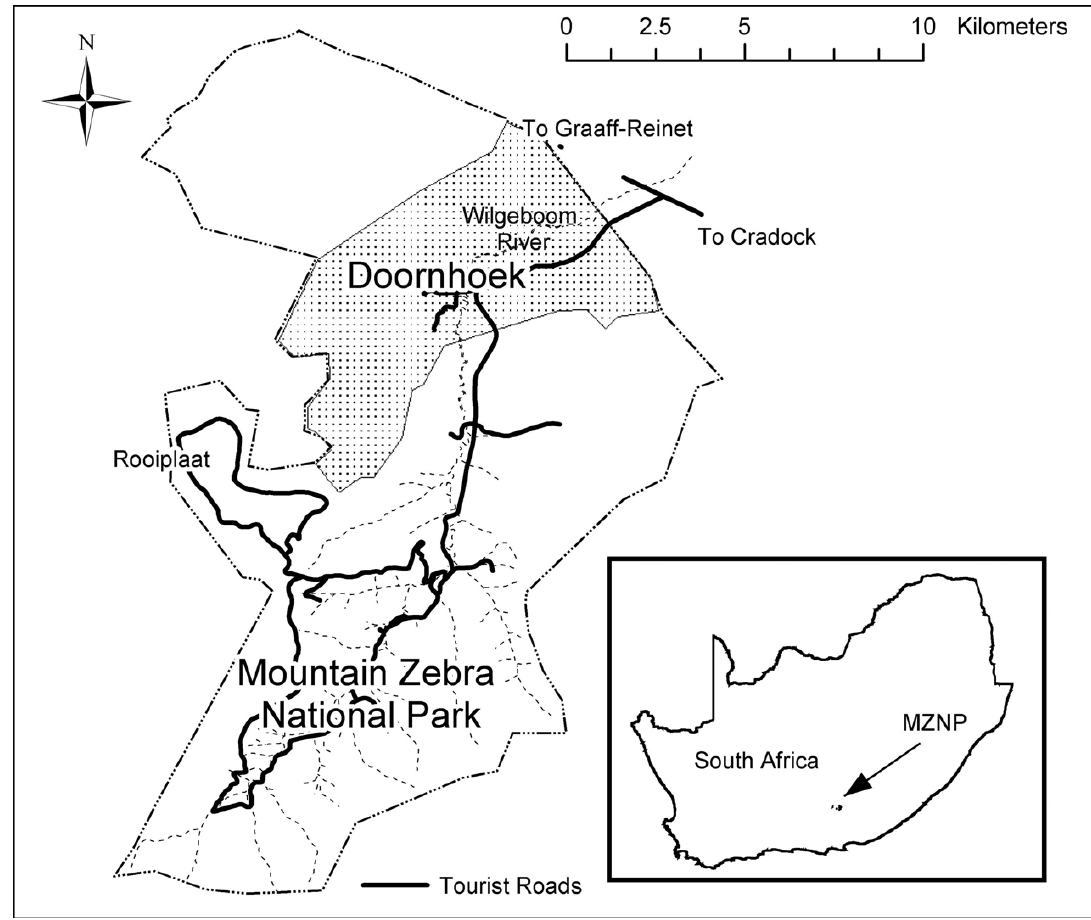
Figure 1 Location of the Mountain Zebra National Park